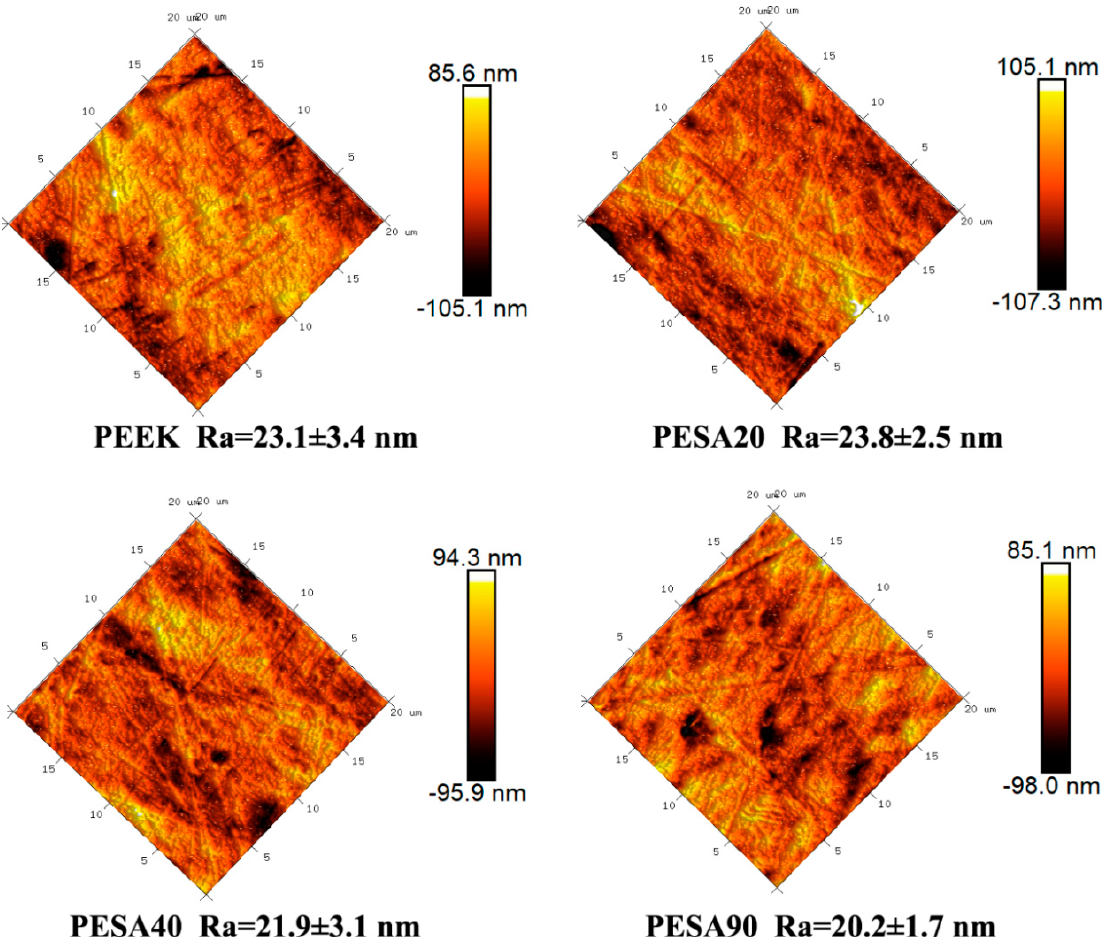
Figure 4. Surface morphology and the corresponding Ra roughness were determined using AFM of PEEK, PESA20, PESA40, and PESA90. All data represent the mean value ± standard deviation ( n = 3 per group).